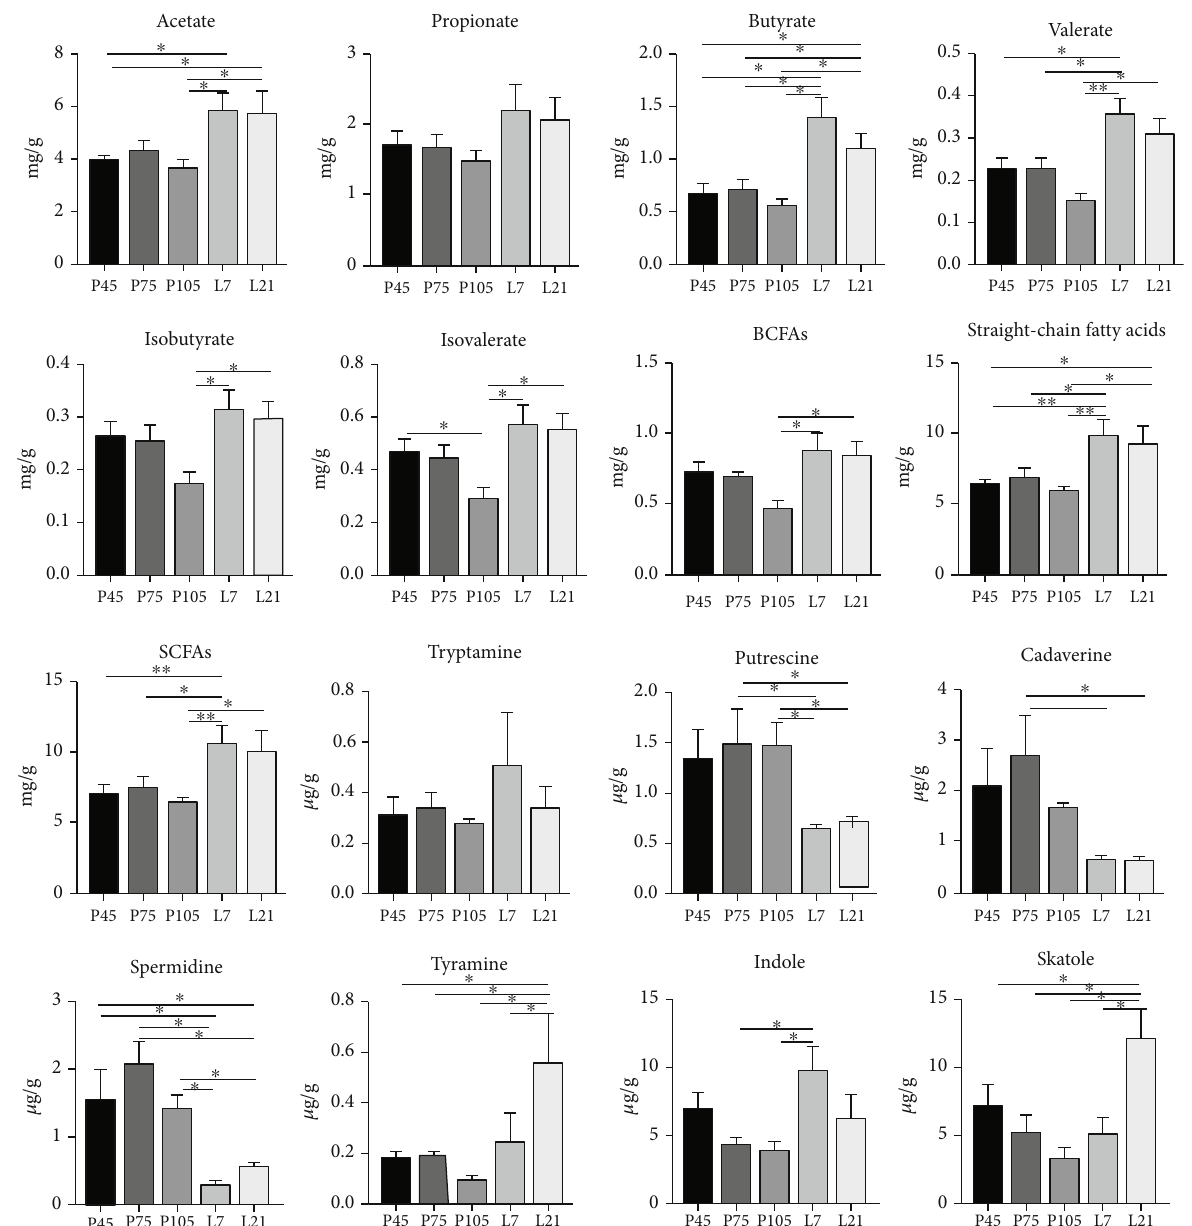
Figure 5: The levels of short-chain fatty acids (SCFAs), bioamines, indole, and skatole of sows at di ff erent stages of pregnancy and lactation. BCFAs: branched-chain fatty acids. Data show the means ± SEM . n = 6 ‐ 8 per